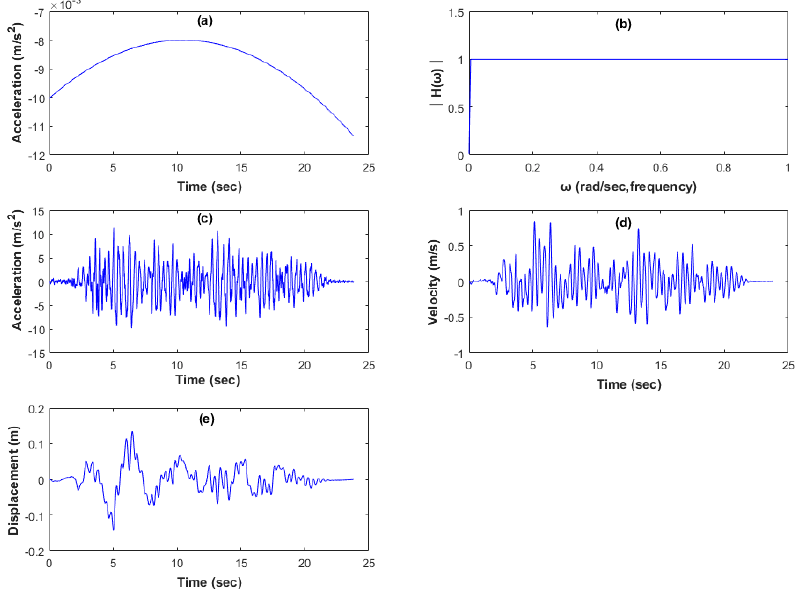
Figure 19. Analysis process for the 10th-story acceleration during the Superstition Hills earthquake using Method 3: ( a ) 2nd-order polynomial equation for correcting acceleration; ( b ) 4th-order Butterworth high-pass filter; ( c ) acceleration; ( d ) velocity; ( e ) displacement.